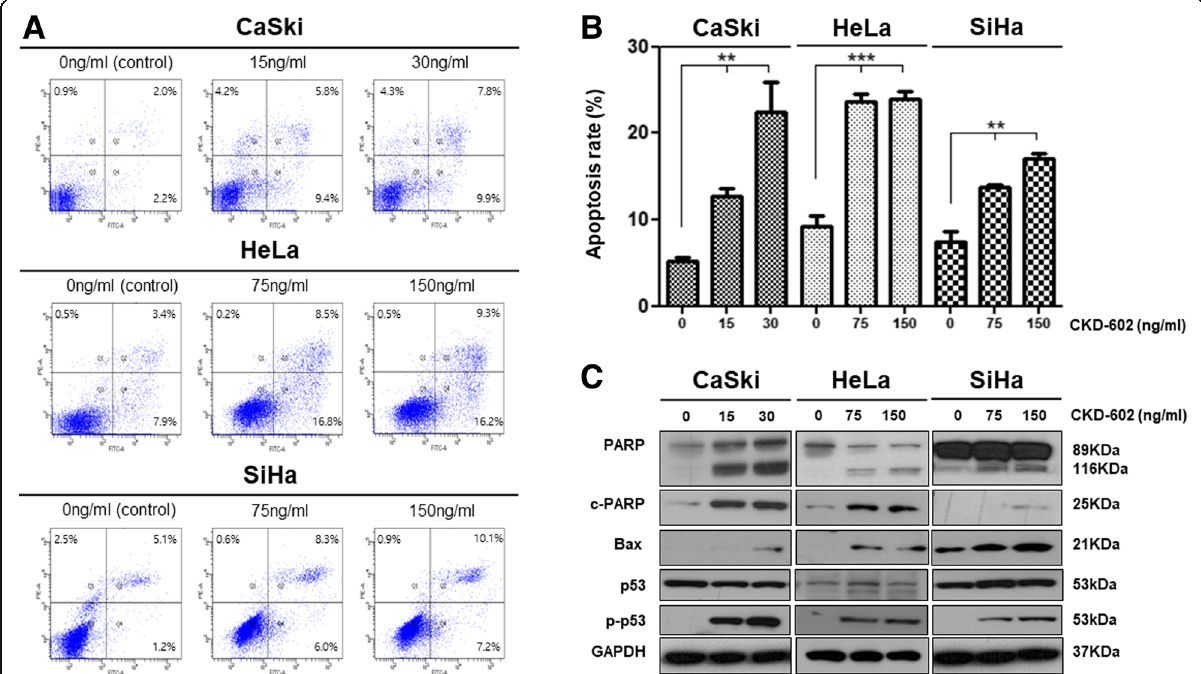
Fig. 1 Pro-apoptotic activity in cervical cancer cells (CaSki, HeLa and SiHa) following CKD-602 treatment. Cells were incubated with CKD602 in a dose-dependent manner (0 [control], ½ IC50, IC50 ng/ml each cells) for 48 h. a. The percentage of apoptosic cells was evaluated using flow cytometic analysis with Annexin V and PI staining. b. The percentage of apoptosic cells measured by flow cytometry. Results are expressed as the mean ± SEM (* p < 0.05 and ** p < 0.01). c. Western blot analysis of apoptosis-related proteins in cervical cancer